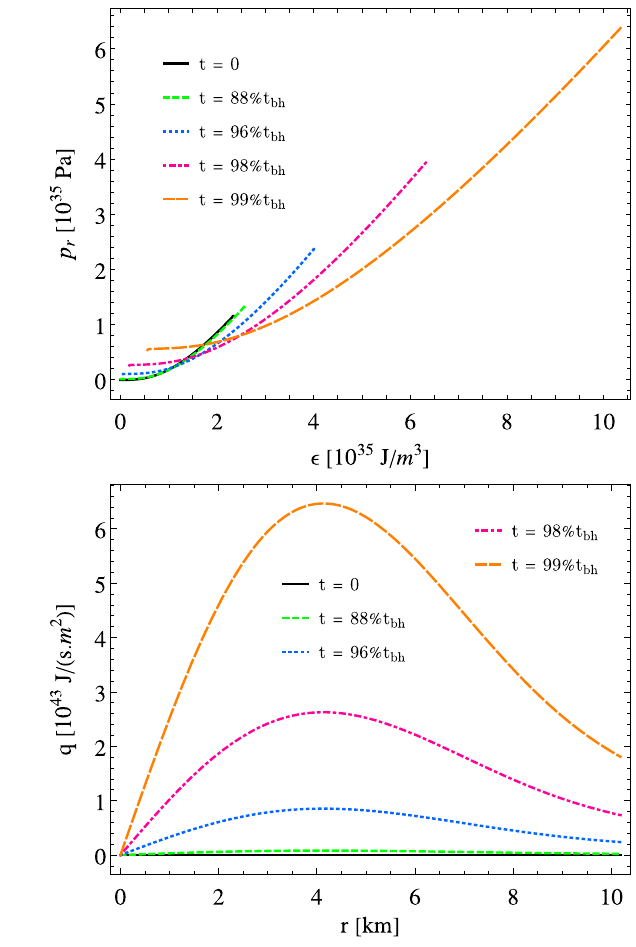
Fig. 5 Energy density (upper panel) and radial pressure (lower panel) as functions of the radial coordinate at different times, for a central mass density ρ c = 2 . 6 × 10 18 kg / m 3 with anisotropy ansatz (32) for β = 0 . 2. This configuration corresponds to an unstable anisotropic BL neutron star with radius R = 10 . 183 km, initial mass M = 2 . 145 M (cid:11) and m bh = 1 . 335 M (cid:11) at the end of the collapse